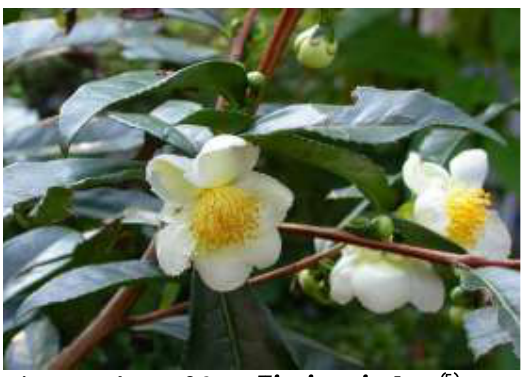
Figure 1. Photo of Camellia sinensis plant (5)